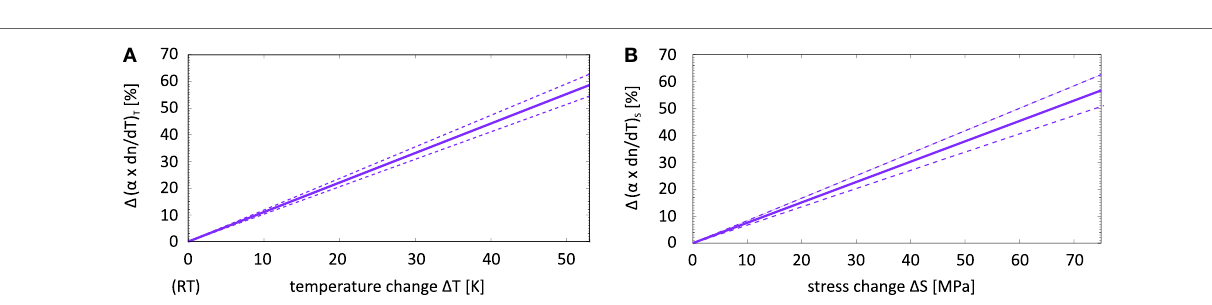
FIGURE 10 | Separated dependence of ∆ ( (cid:11) (cid:2) dn/dT) on temperature and on stress. (A) shows the temperature dependence of the change in (cid:11) (cid:2) dn/dT for a temperature range of 290–333K. (B) shows the change in (cid:11) (cid:2) dn/dT versus stress for a stress range of 110.6–189.5MPa. The dashed lines show the error bars as given by equations (3) and